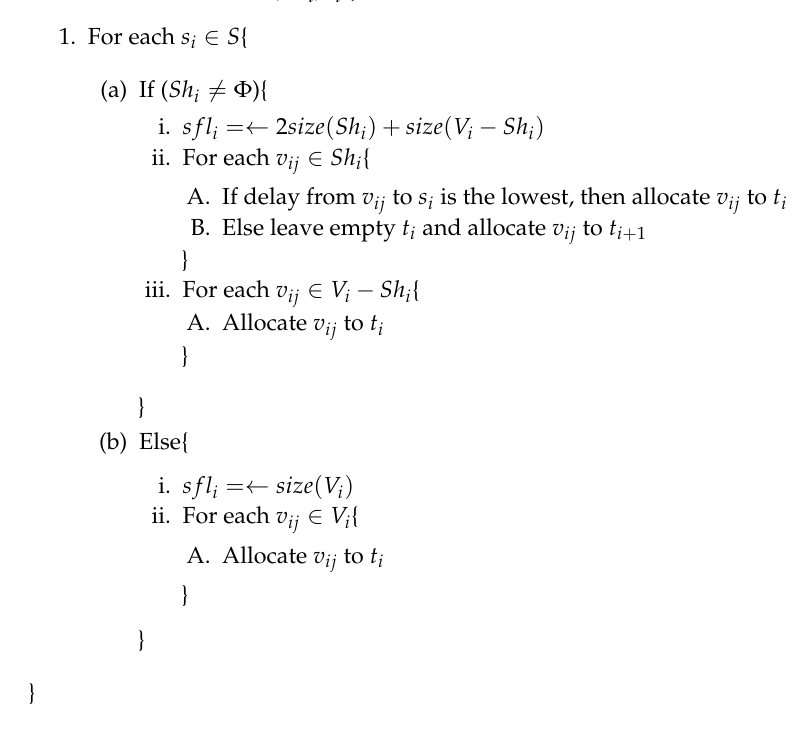
Figure 5. Algorithm for the slot allocation.